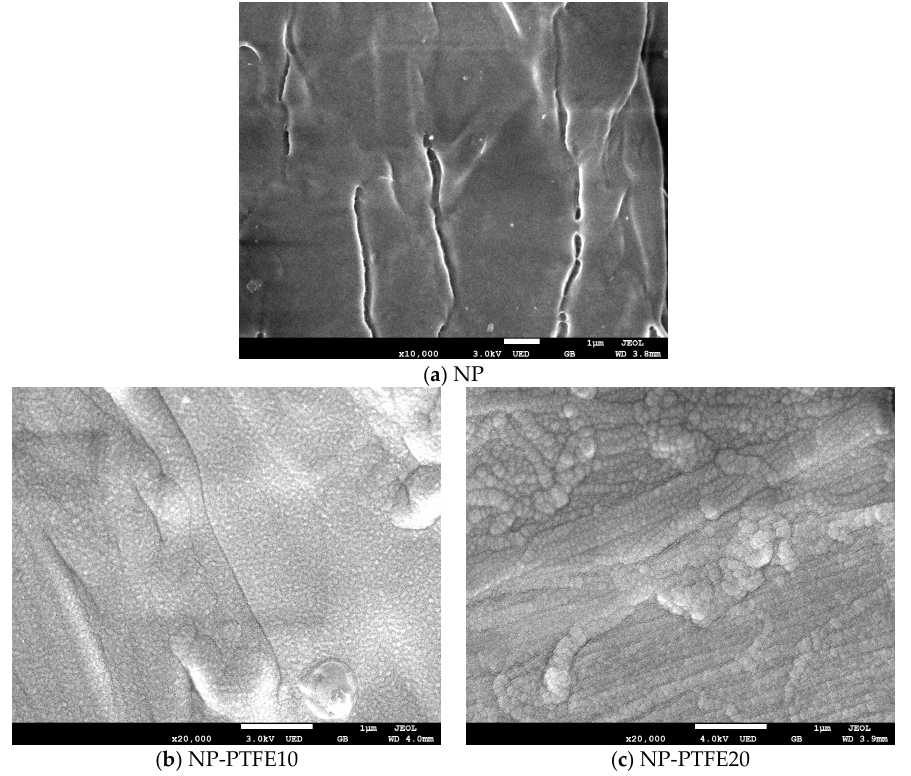
Figure 7. The scanning electron microscopy (SEM) of the new pressboard, pressboard surface coated PTFE film for 10 min and 20 min.